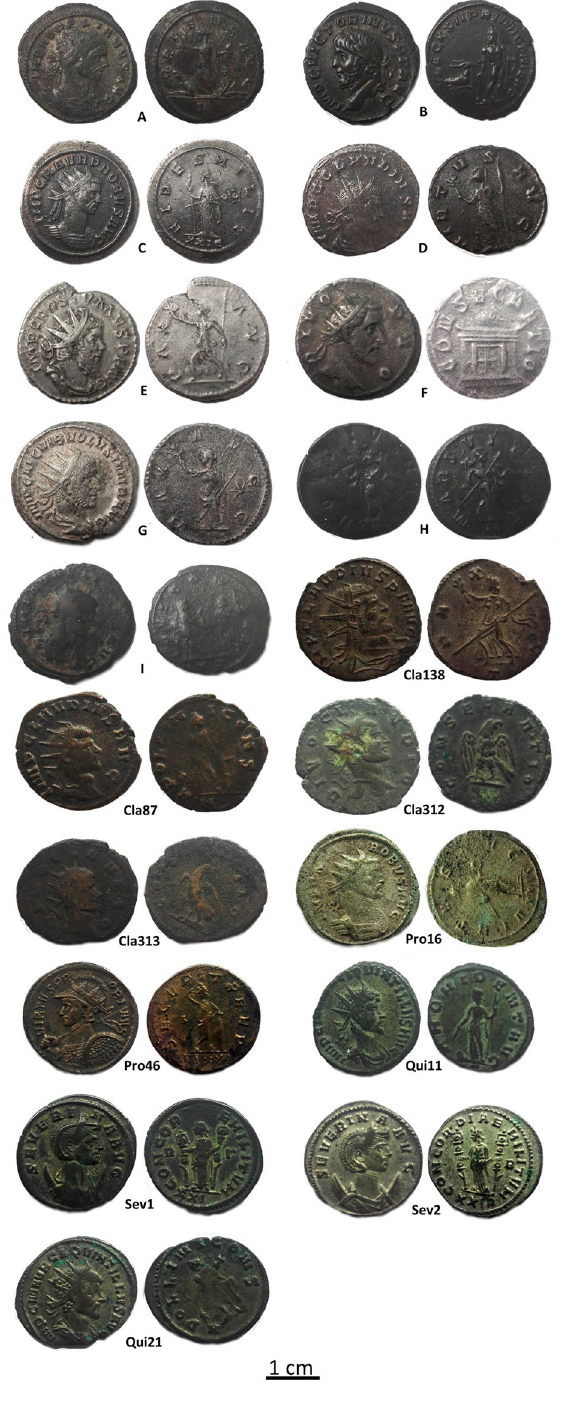
Figure 1. The Antoninianus coins studied in this work. All the historical information are reported in Supplementary Table